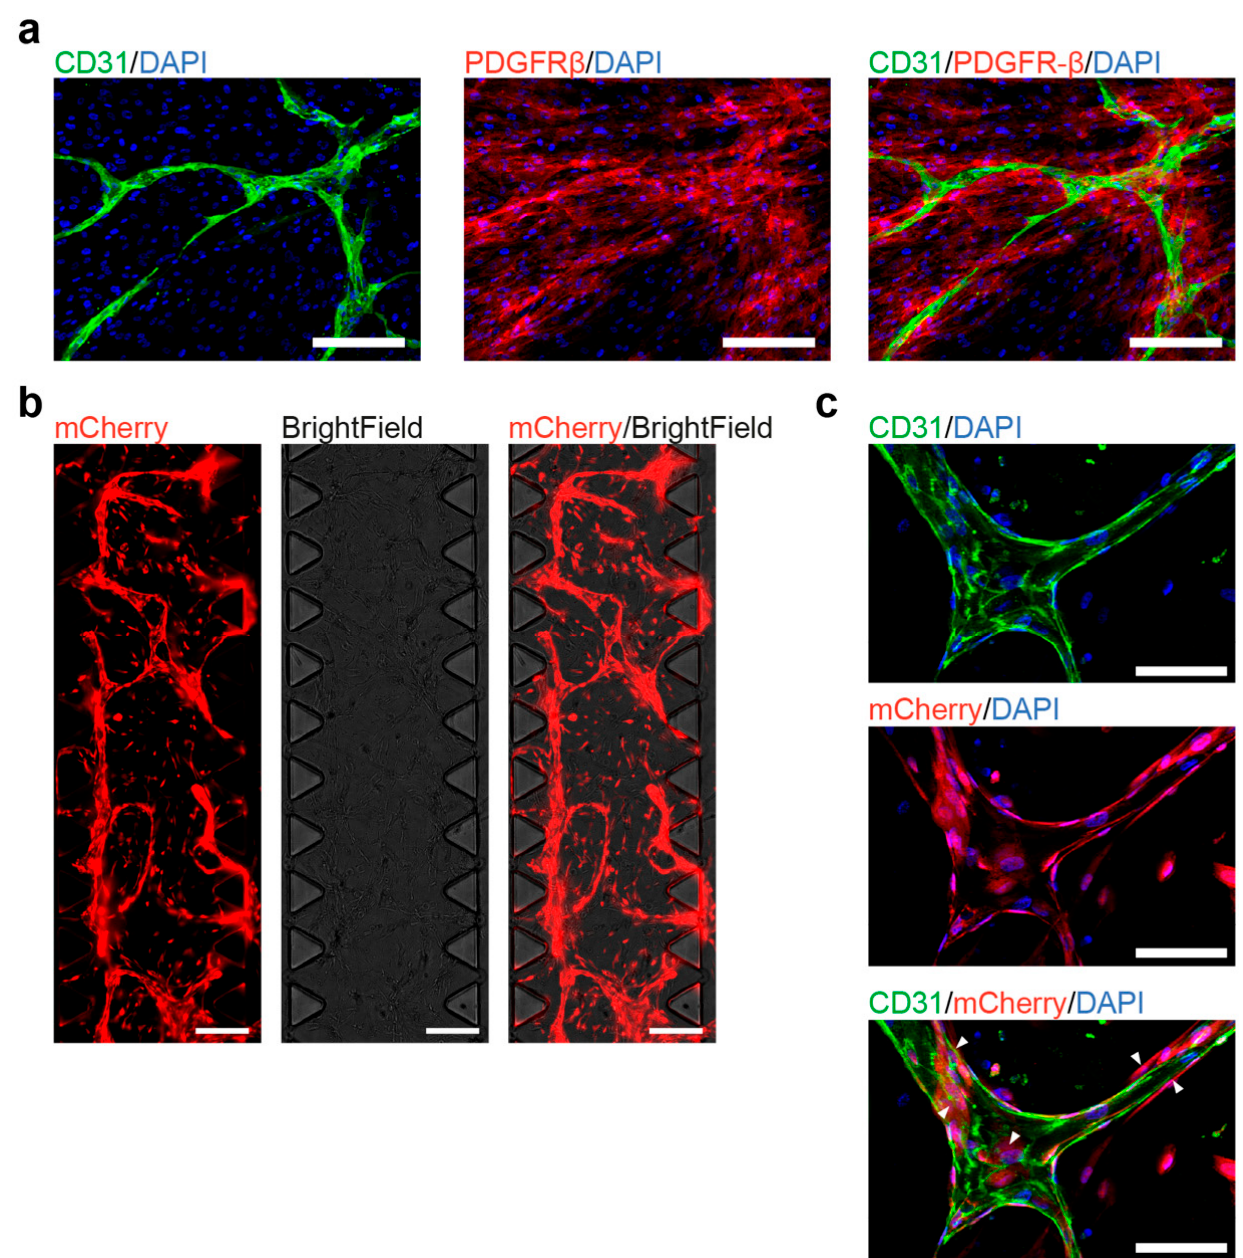
Figure 4. Co-culture of human induced pluripotent stem cells (hiPSC)-derived endothelial cells (ECs) and pericytes. ( a ). Co-cultured hiPSC-derived ECs and pericytes form blood vessel-like structures in vitro under 2D culturing conditions. Fluorescent imaging shows blood vessel-like structures that contain ECs (positively stained for CD31) and pericytes (positively stained for Platelet Derived Growth Factor Receptor β (PDGFR- β )); scale bars: 100 µm. ( b ). Co-cultured hiPSC-derived ECs and pericytes form a 3D microvascular network in the chip. Live-cell imaging, both ECs, and PCs express mCherry for visualization; scale bars: 1 mm ( c ). Fluorescent imaging shows the 3D microvascular network in the chip, ECs and PCs express mCherry, ECs are positively stained for CD31. White arrows show the colocalization of pericytes with ECs; scale bars: 100 µm.